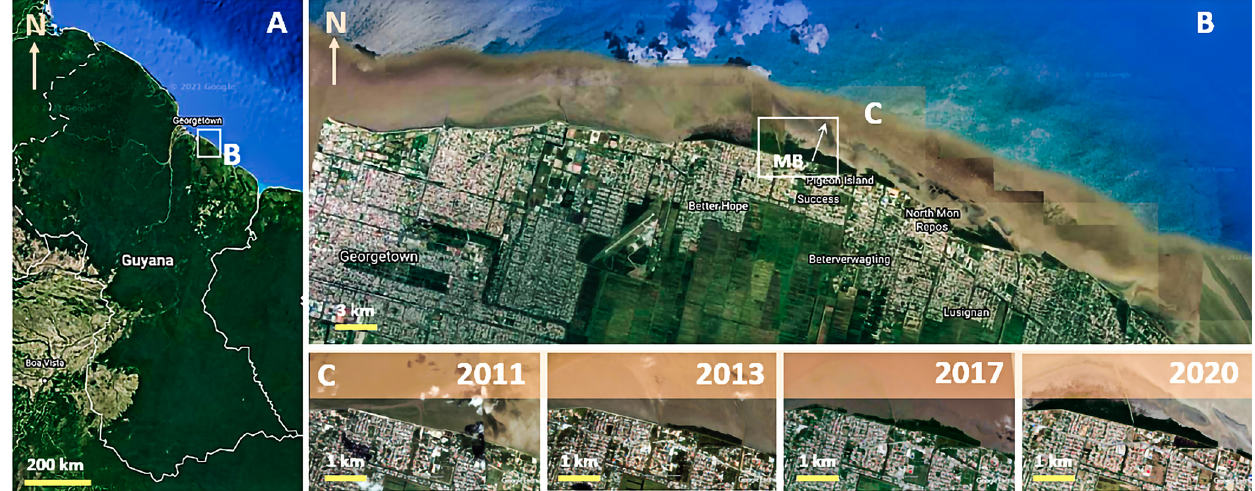
Figure 1. (A, B) Satellite imagery of the data collection site along the Chateau Margot coastline located on the northeastern coastline of Guyana, with the location of the transect used for the measurements (MB). (C) A timeline for the development of the mangrove fringe between 2011–2020. Here the mangrove area is shown in 2011 (prior to the restoration works) and in 2020. Over the last 10 years, the fringe has developed a width ranging from 120 to